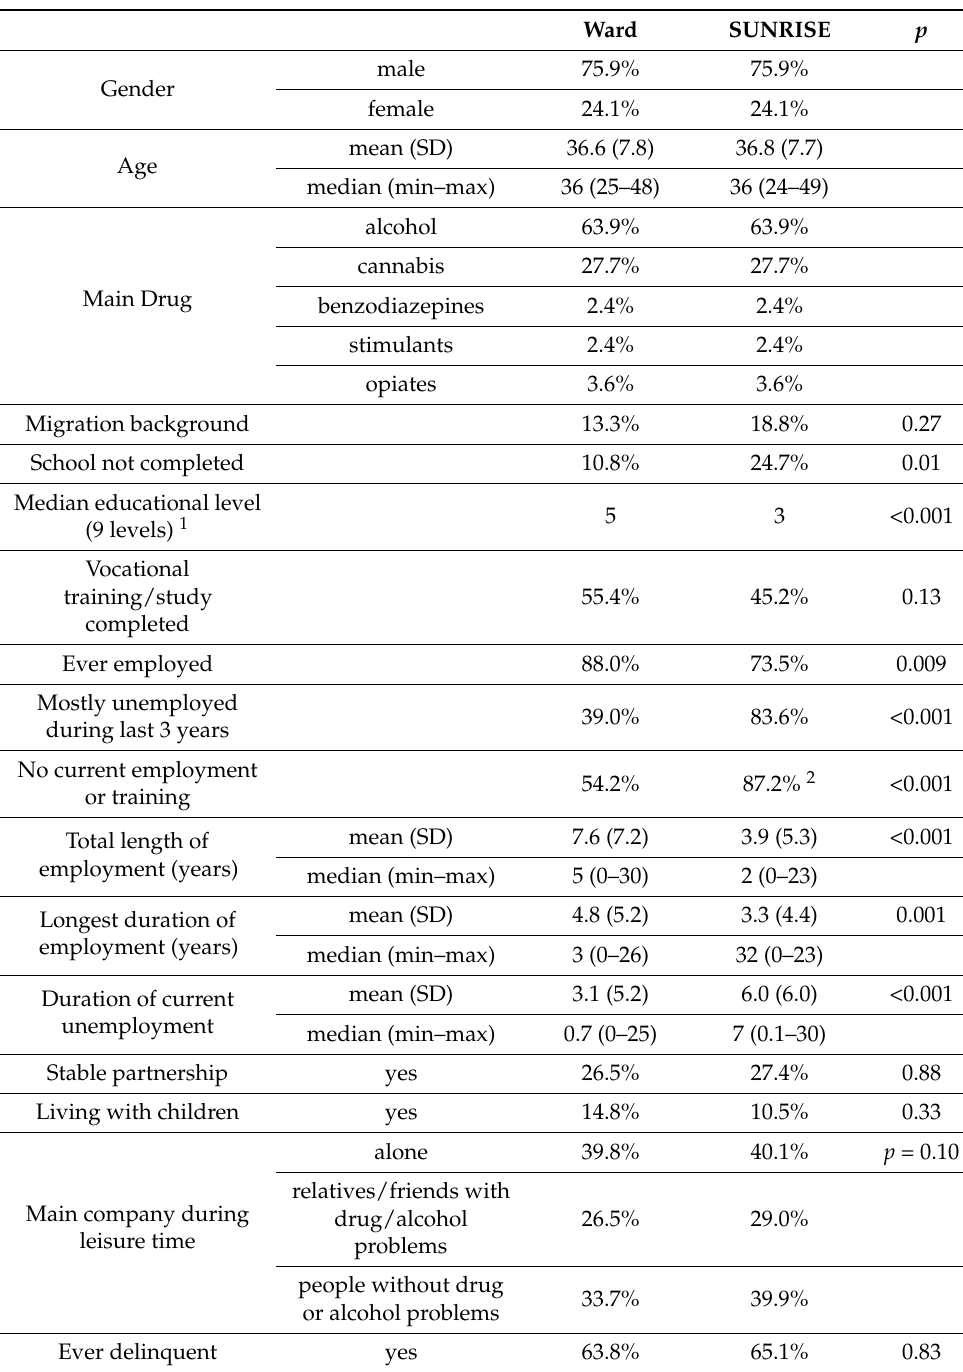
Table 1. Comparison of sociodemographic characteristics comparing clinical sample (ward; n = 83) and unemployment office sample (SUNRISE; n =